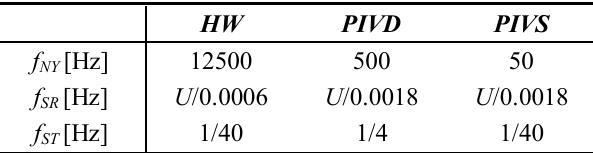
Table 2. Spectral frequency